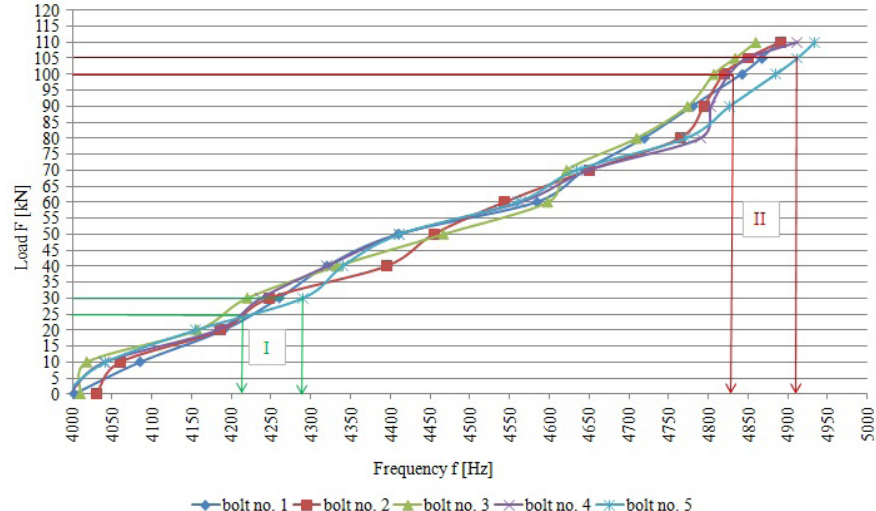
Figure 9: Load and frequency behavior of the expansion-shell bolt with a length of 1.82 m.